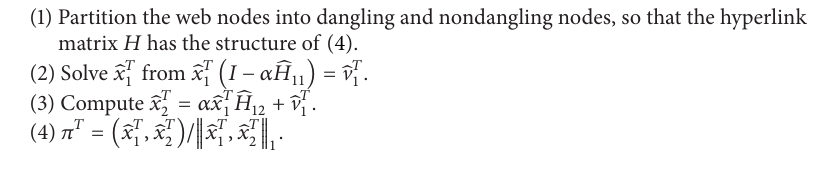
Algorithm 1: Reordered PageRank Algorithm [22].